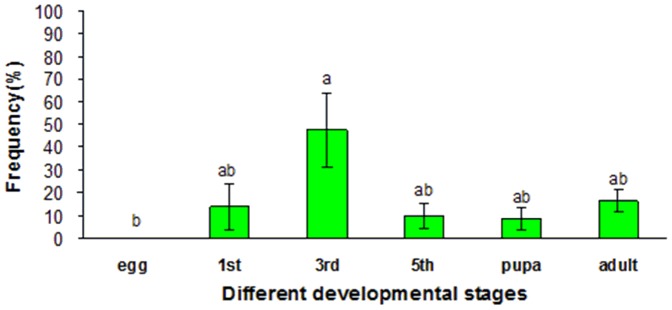
The usage frequencies of OfRyR optional exon c in different developmental stages of O. furnacalis.Optional exon c was indicated by green bars. 1st, 3rd and 5th denotes first-instar, third-instar and fifth-instar larva. Different letters above each bar indicated statistical difference by ANOVA followed by the Duncan's Multiple Comparison test (P<0.05).